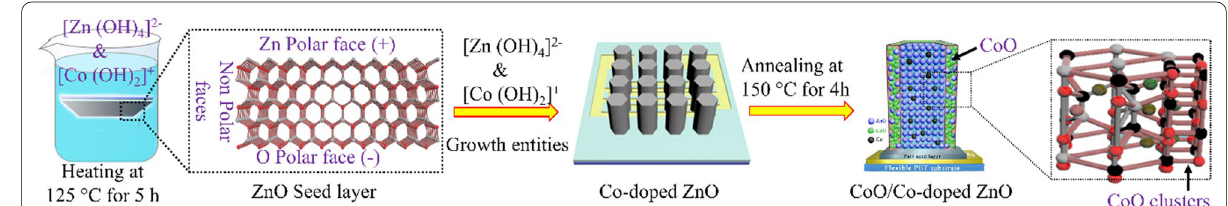
Fig. 1 Schematic illustration of the CO/CZO heterostructure nanorods at low temperature on PET